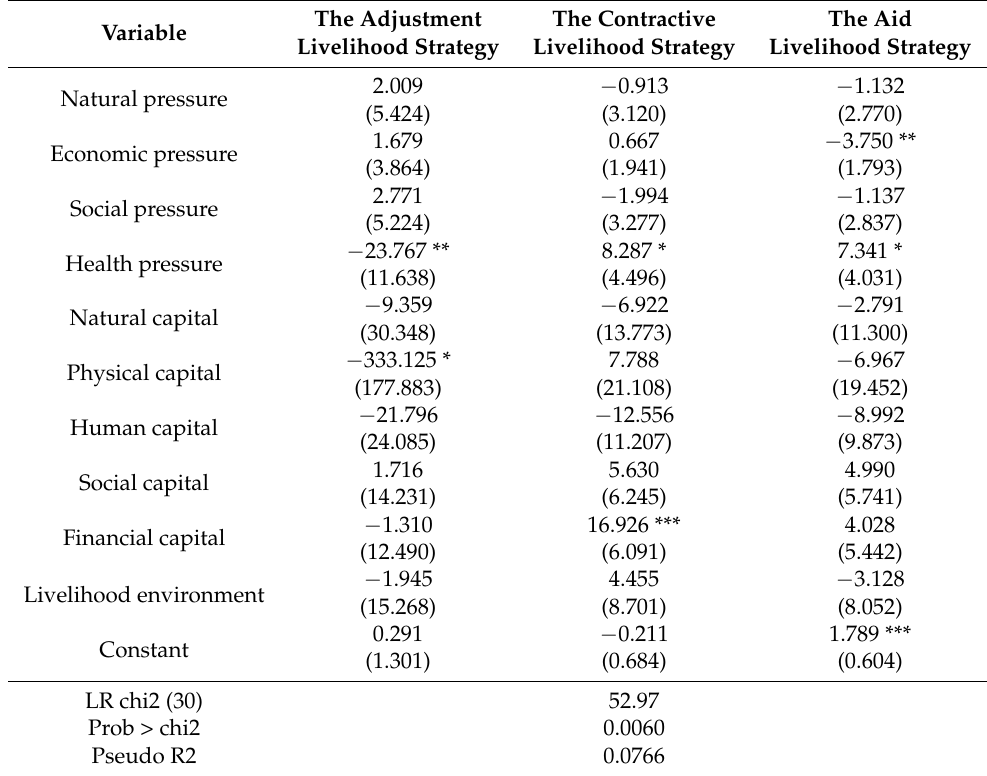
Table 3. Comprehensive index of adaptability of rural households in earthquake-stricken